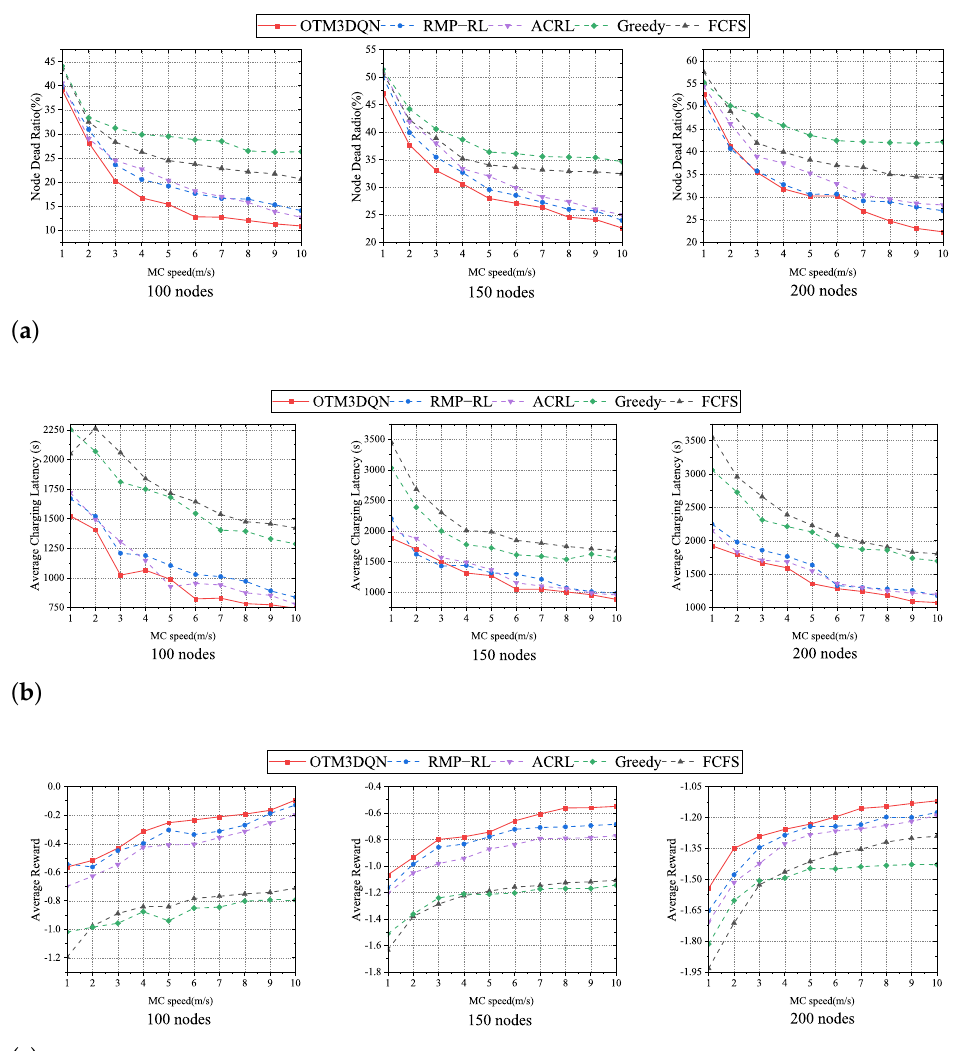
Figure 8. Impact of MC speed. ( a ) Node dead ratio under different MC speed. ( b ) Average charging latency under different MC speed. ( c ) Average reward under different MC